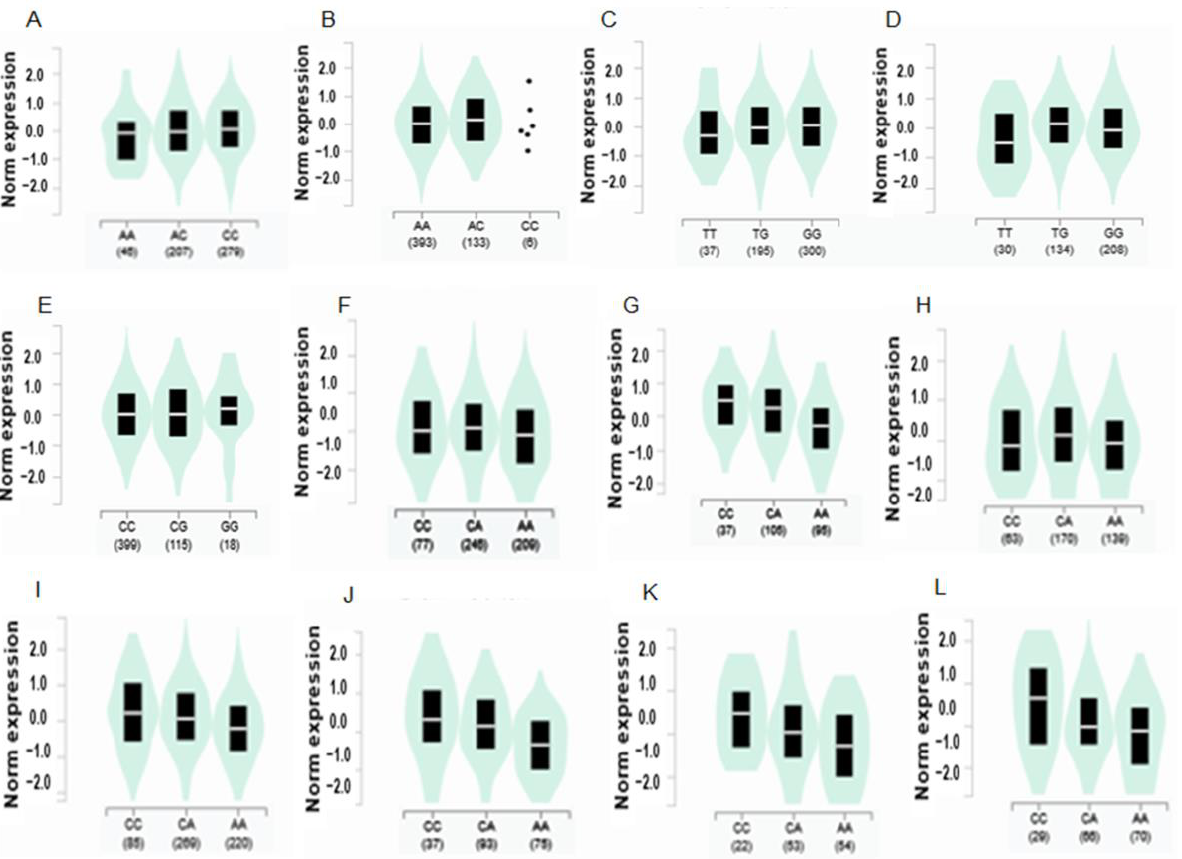
Figure 3. Gene expression according to the alleles of the selected SNPs for high body fat risk in different tissues. The black box indicated the box plot of norm expression of the gene according to each allele. The middle line was the median of the norm expression of gene with each allele. The green bell shape showed the distribution of norm gene expression with each allele. ( A )